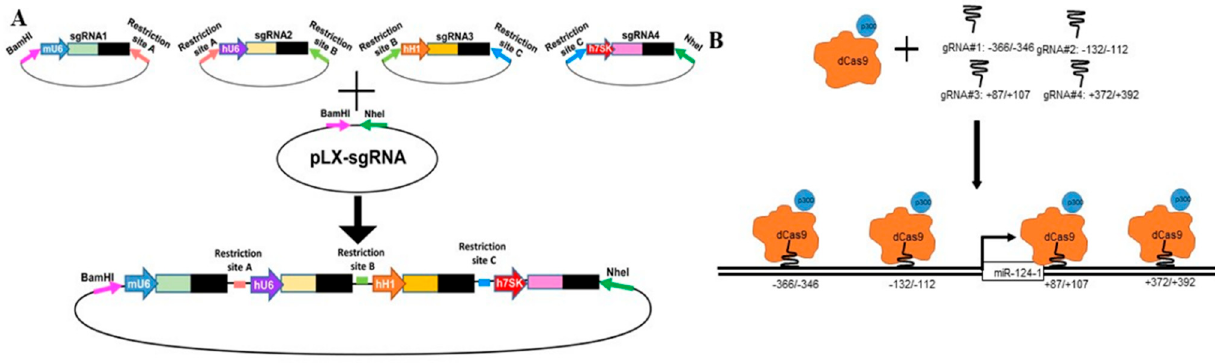
Figure 5. miR-124-1 gene in human PH-Fibs is more condensed (closed), compared to that in CO-Fibs, as evidenced by increased levels of H3K27Me 3 , a mark of closed chromatin. HDACi decreases the H3K27Me 3 levels and increases the H3K27Ac (mark for open chromatin) levels on the promoter or enhancers of miR-124-1 gene in PH-Fibs. Antibodies against H3K27Me 3 ( A ) or H3K27Ac ( B ) were used to pull down chromatin prepared from CO-Fibs ( n = 3) or PH-Fibs ( n = 3) or PH Fibs treated with HDACi ( n = 2), then qPCR were used to evaluate the precipitated miR-124-1 genomic DNA at its promoter (-110/-4), proximal promoter (-240/-160) and enhancers (-711/-590 and -1543/-1466). Data are presented as mean ±S.E.M, # p < 0.05, ## p < 0.01 vs. CO-Fibs; * p < 0.05, ** p < 0.01 vs. PH-Fibs DMSO.